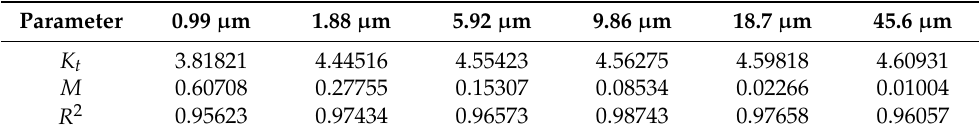
Figure 4. Cumulative residue and fitting curves for six representative sieve sizes. Table 4. Parameters of grinding equations for six representative sieve